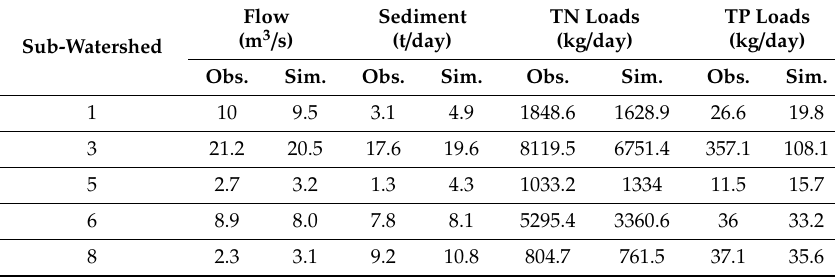
Table 5. Comparative results of streamflow and water quality